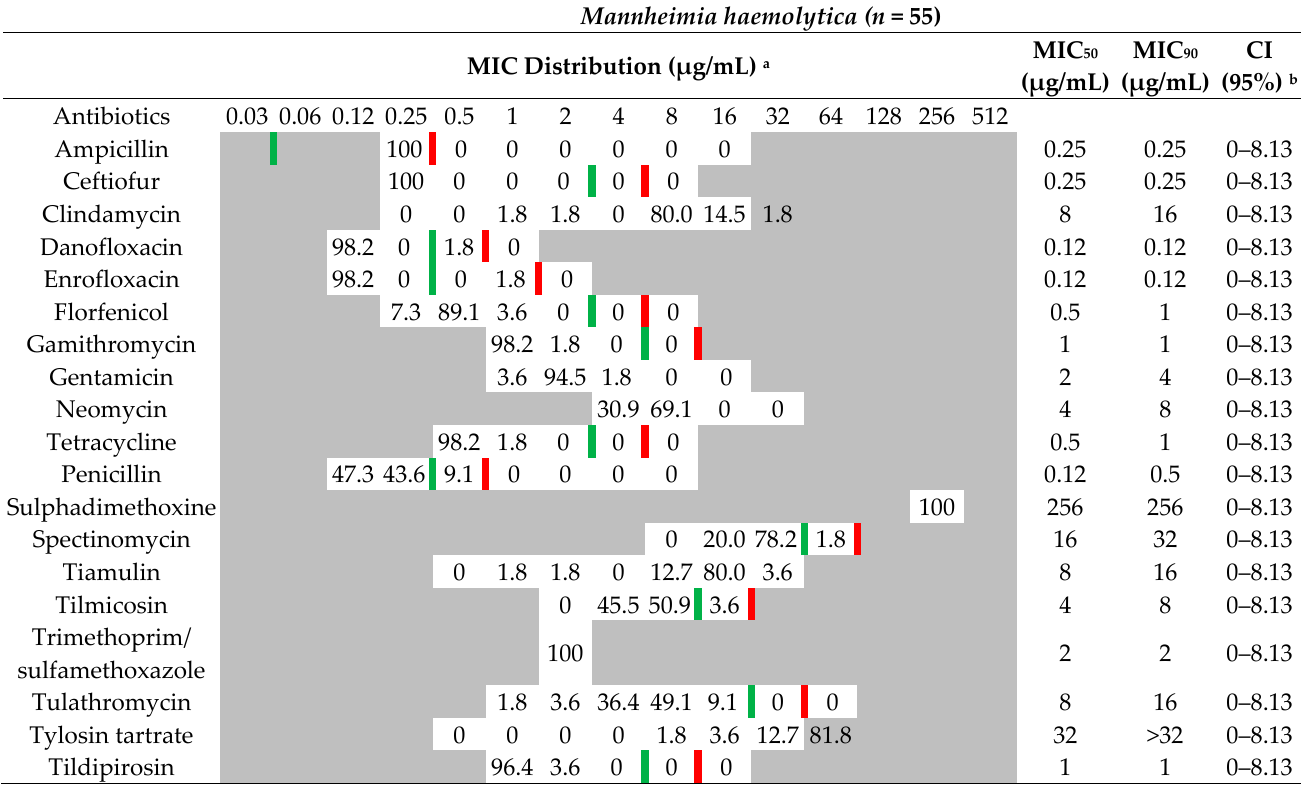
a The dilution ranges for the percentage of the isolates tested are those contained in the white area. Values above this range indicate MIC values higher than the highest concentration tested. Values corresponding to the lowest concentration tested indicated MIC values lower or equal to the lowest concentration within the range. When available, susceptible and resistance breakpoints are indicated in vertical green and red lines, respectively. Cut-off values were used according to CLSI document VET08. b Confidence interval based on %